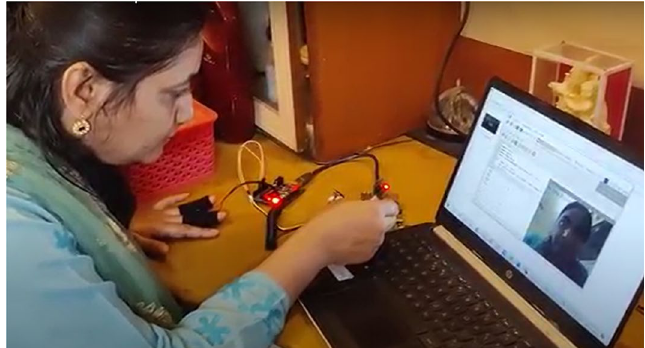
Fig. 8 Proposed emotion detection Setup with GSR and visual FER method